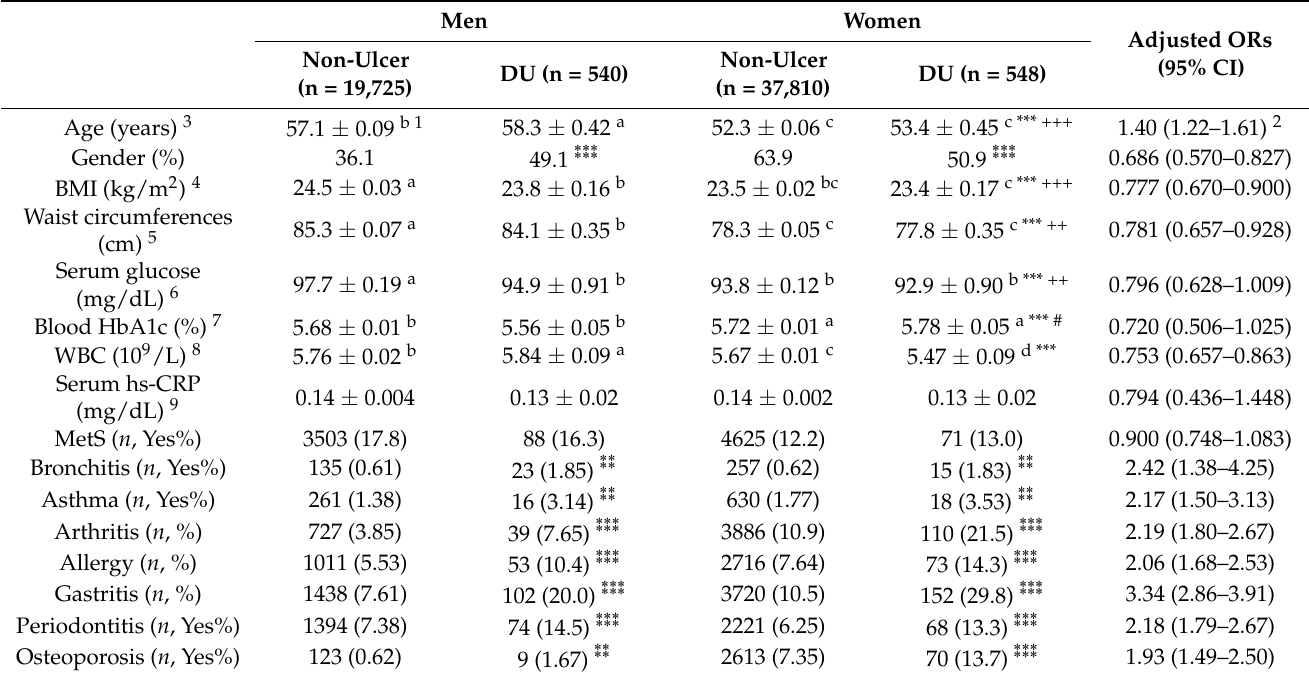
1 Values represented adjusted means ± standard error for continuous variables and the number and percentages of participants for categorical variables. 2 Adjusted odds ratio (OR) and 95% confidence intervals (CI). Covariates included age, sex, education, income, energy intake (percentage of esti- mated energy requirement), residence areas, daily activity, alcohol intake, and smoking status. The cutoff points of the reference for logistic regression are as follows: 3 <55 years; 4 <25 kg/m 2 for body mass index (BMI); 5 <90 cm for men and 85 cm for women waist circumferences; 6 <126 mL/dL fasting serum glucose plus diabetic drug intake; 7 <6.5% hbA1c plus diabetic drug intake; 8 <4.0 × 10 9 /L white blood cells (WBC); 9 <1.0 mg/dL high-sensitive C-reactive protein (hs-CRP). *** Significant differences by genders at p < 0.001. ++ Significant differences by DU at p < 0.01, +++ p < 0.001. # Significant interac- tion between genders and DU at p < 0.05. ⁑⁑ Significantly different from the control group in χ 2 test in each gender at p < 0.01, ⁑⁑⁑ at p < 0.001.a,b,c ,d Different superscripts on bars indicate significant differences among the groups at p < 0.05.